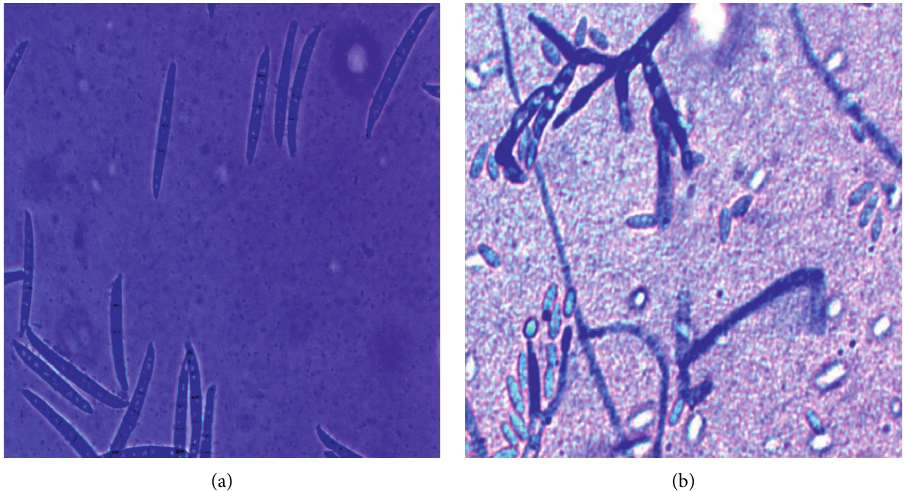
Figure 1: (a) Conidia for F. equiseti. (b) Conidia for F. verticillioides